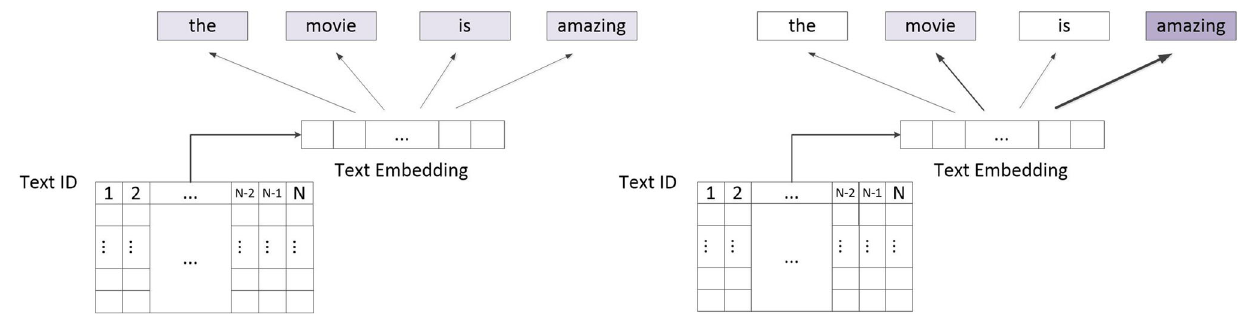
Fig. 2 Illustration of PV-DBOW ( left ) and weighted PV-DBOW (